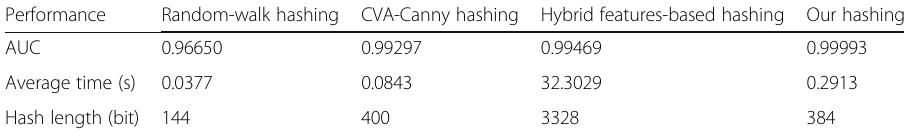
Table 7 Performance summary of different algorithms